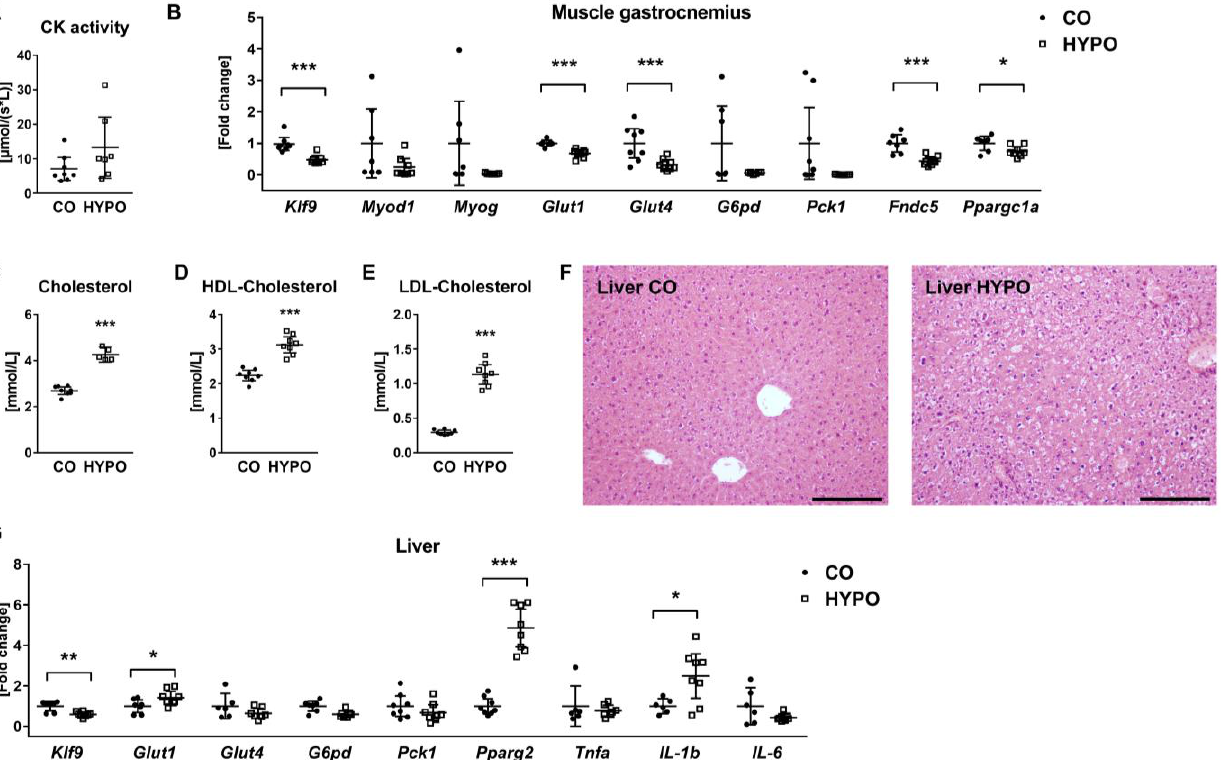
Figure 3. Hypothyroid mice display reduced mRNA expression of glucose transporters Glut1 and Glut4 in muscle together with high serum cholesterol and pathological changes in liver tissue. Muscle, serum, and liver tissue from 16-week-old male hypothyroid (HYPO) and control (CO) mice were collected and tested using Cobas 8000 modular analyzer, real-time PCR analysis, and histology. ( A ) Creatine kinase serum levels and ( B ) mRNA expression of Klf9 , myoblast differentiation marker genes MyoD1 and Myog , glucose transporters Glut1 and Glut4 , G6pd , Pck1 , Fndc5 , the precursor for irisin, and its transcriptional regulator Pppargc1a in muscle tissue are compared between control and hypothyroid mice. Further, serum levels of ( C ) cholesterol, ( D ) HDL-cholesterol, and ( E ) LDL- cholesterol were determined. ( F ) Representative pictures of HE-stained liver sections. ( G ) mRNA expression of Klf9 , Glut1 , Glut4 , G6pd , adipocyte marker Ppparg2 , and proinflammatory cytokines Tnfa , IL-1b , and IL-6 is shown in liver tissue for control versus hypothyroid mice. Each dot indicates an individual mouse. The horizontal lines represent the mean ± 95% CI. Serum analyses: N = 8 per group; real-time PCR: CO: N = 7, HYPO: N = 8. Statistical analysis was performed by Student’s t -test: * p < 0.05; ** p < 0.01; *** p < 0.001 vs.